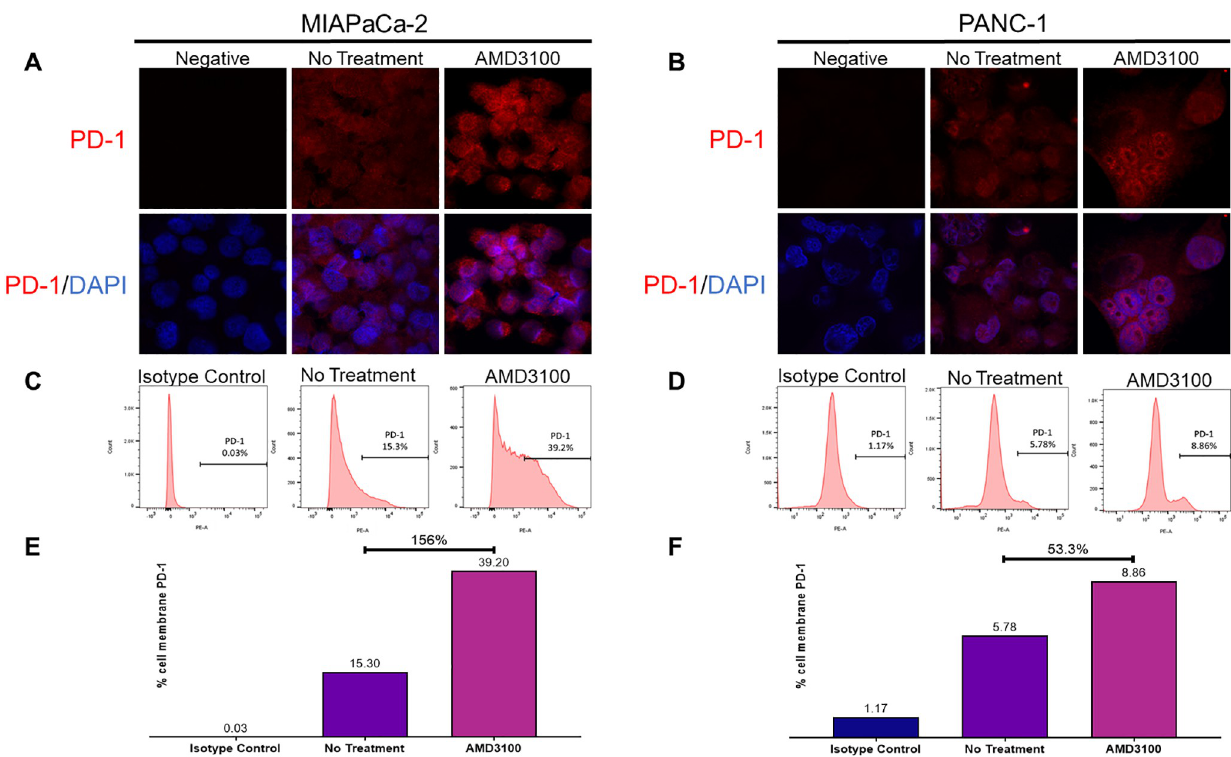
Fig 4. CXCR4 inhibition leads to PD-1 translocation to the cell membrane. ( A, B ) Immunofluorescence analysis of MIAPaCa-2 and PANC-1 PDAC cells. Treatment with AMD3100 resulted in increased PD-1 cell surface expression compared to controls (magnification 100x). ( C, D ) Flow cytometry analysis of PDAC cells. Cells were treated with AMD3100, isotype antibody, or solvent control and then prepared for flow cytometry analysis of PD-1 membrane expression. Treatment with AMD3100 revealed increased surface expression of PD-1 compared to controls. ( E, F ) Quantification of flow cytometry analysis demonstrated 156% and 53.3% increase in cell surface expression of PD-1 after AMD3100 treatment.